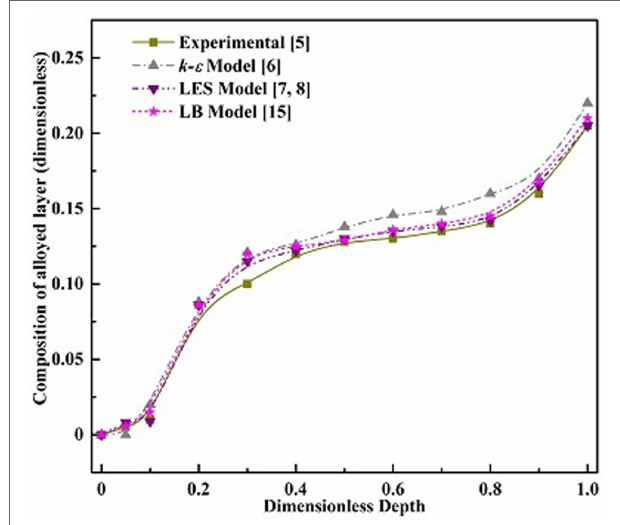
FIGURE 5 | Composition of the solidified layer along the depth of the pool obtained from different models and experiment .